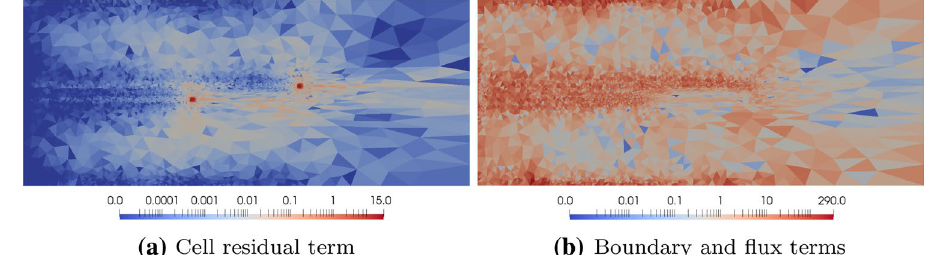
(d) Anisotropic adaptation (6,442 elements, max. aspect ratio 8.7, QoI 23.3632 kW)